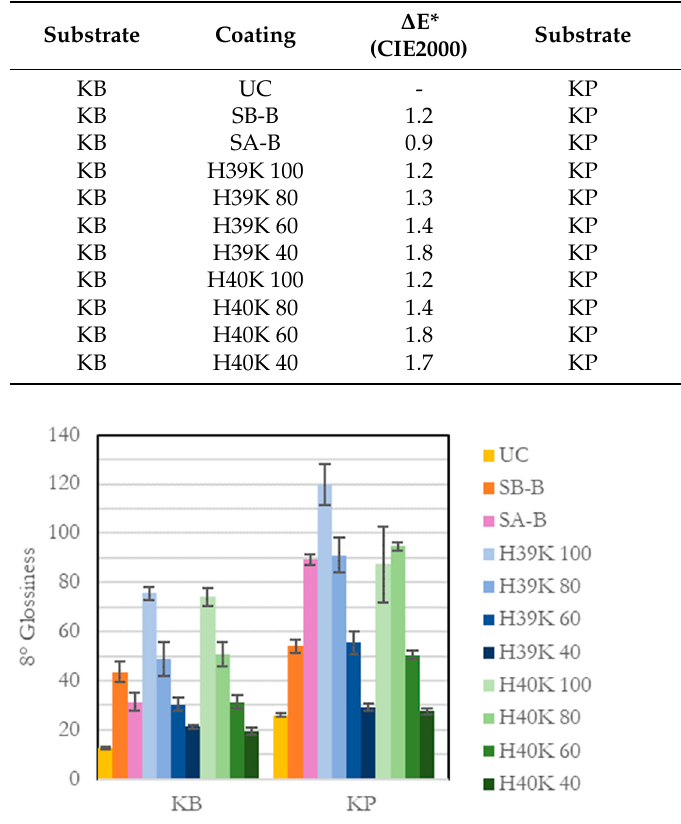
Table 3. Experimental coating formulations for the HPH 39 and HPH 40 styrene-butadiene latex.